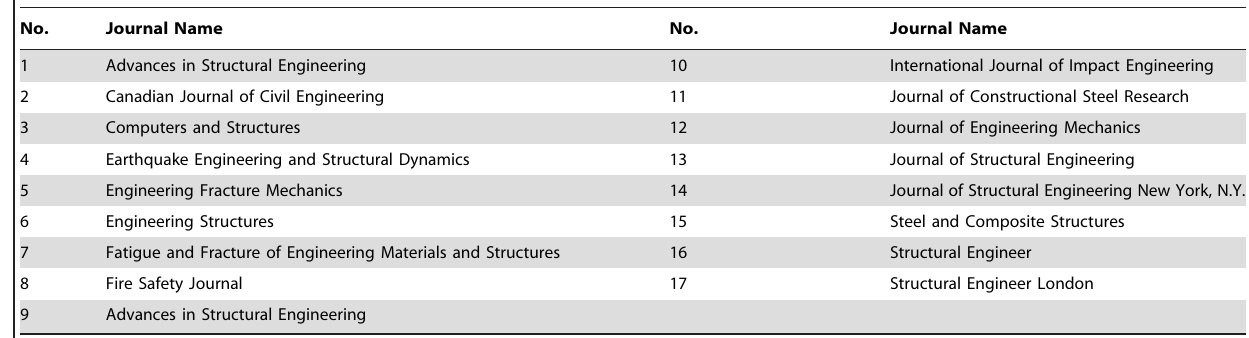
Table 1. List of journals.